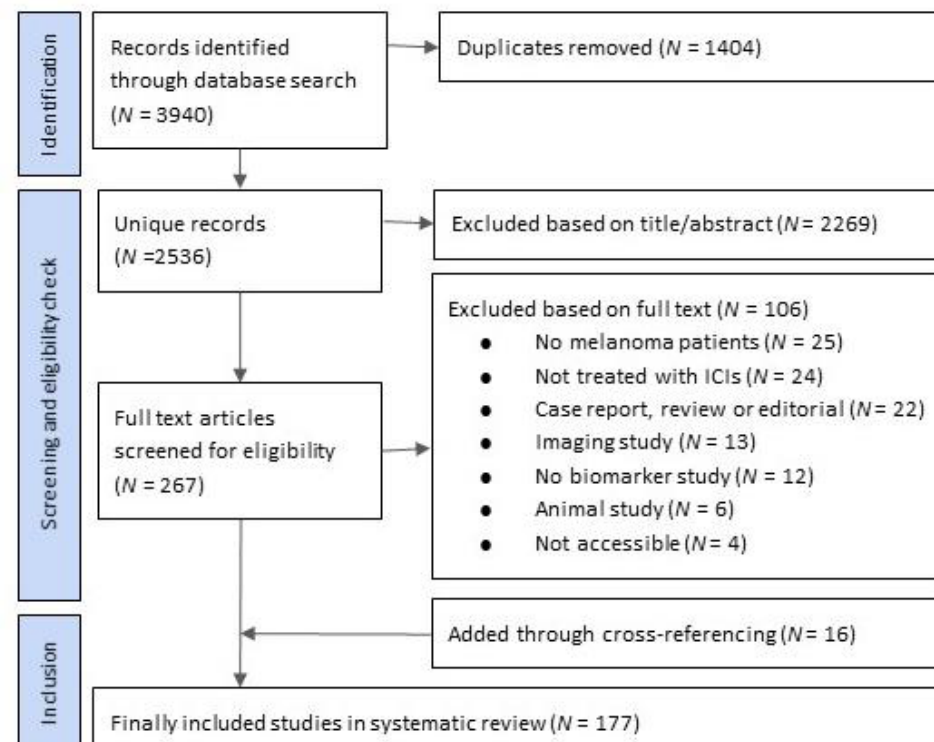
Figure 1. Study selection based on PRISMA methods.